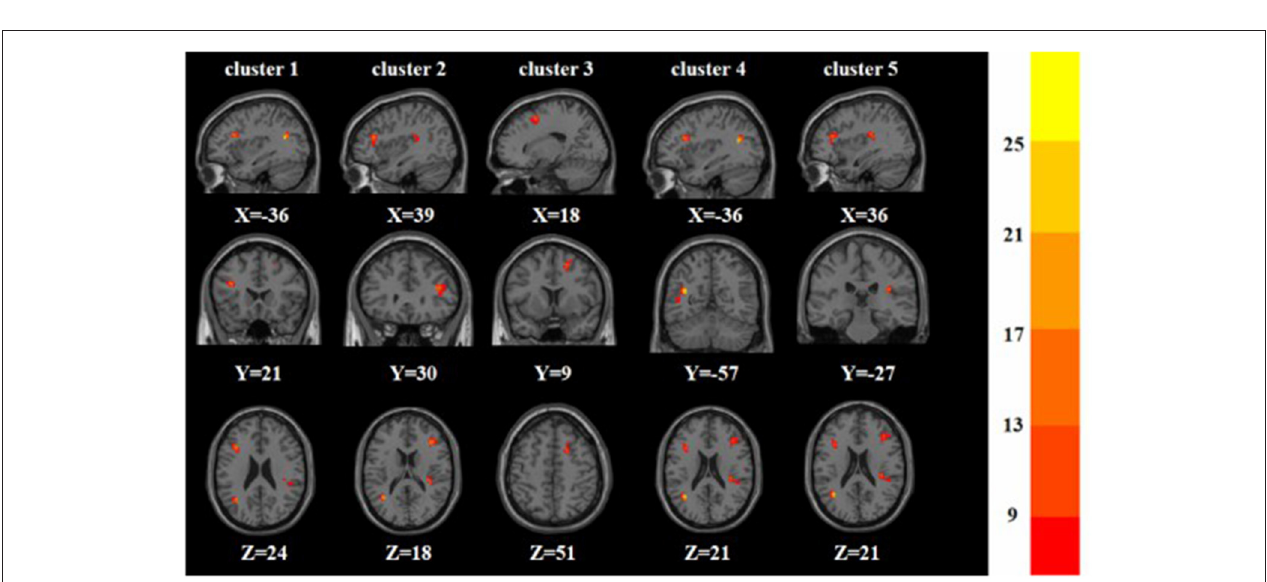
FIGURE 1 | Based on one-way ANOVA for three groups of ALFF abnormal brain regions. The color bars indicate the F -value.